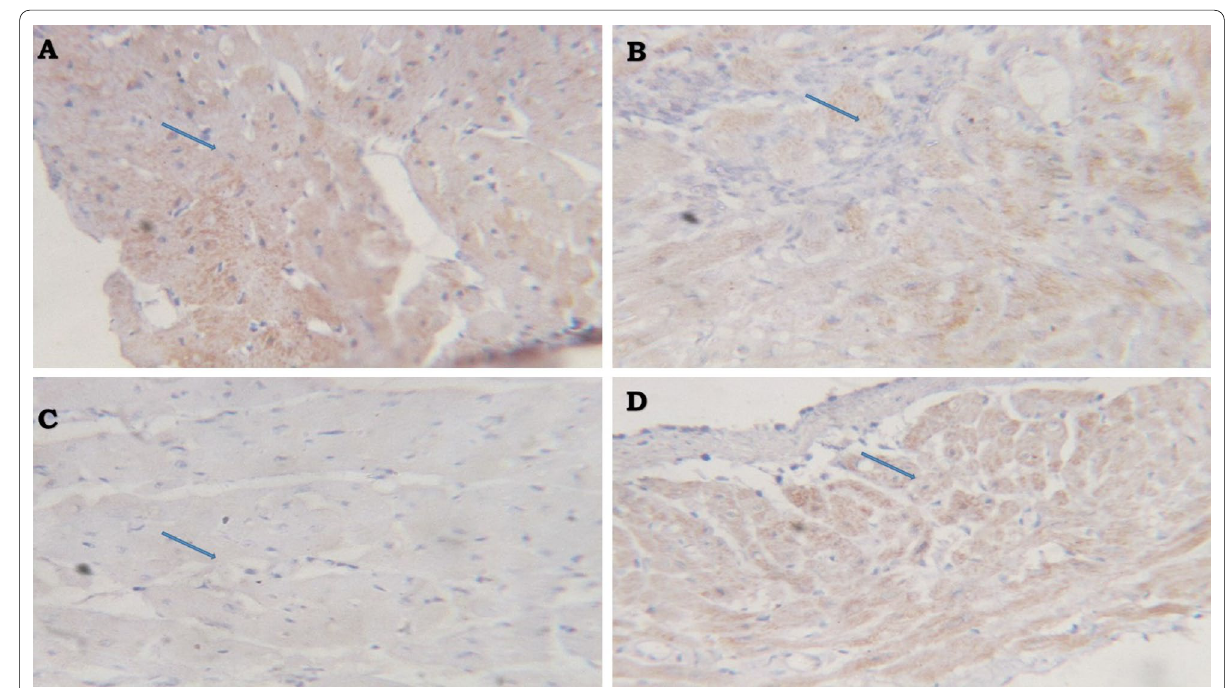
Fig. 3 Photomicrons A–D are group representative photographs of FATP/CD36 cardiac tissue expression in rats ( immunohistochemical staining in control. B Represents immunohistochemical staining in salt-induced insulin-resistant group of rats. C Represents immunohistochemical staining in sucrose-induced insulin-resistant group of rats. D Represents immunohistochemical staining in high fat-induced insulin-resistant group of